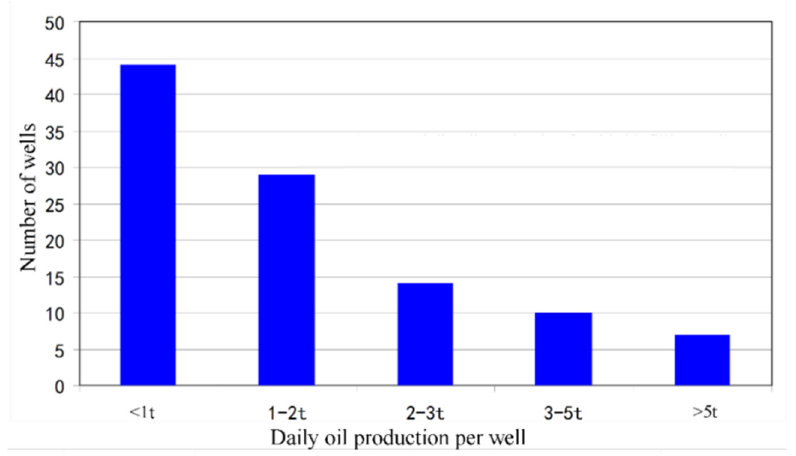
Figure 5. Daily production for third infilling wells at the initial production stage, with average of 2.04 t.